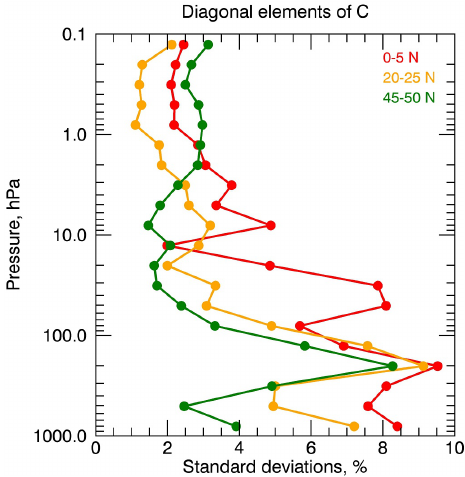
Fig. 4. Vertical profiles of the square roots of diagonal elements of the covariance matrix for three latitude bins as percent relative to the a priori. These quantities are equal to the standard deviations of the mzm profiles.